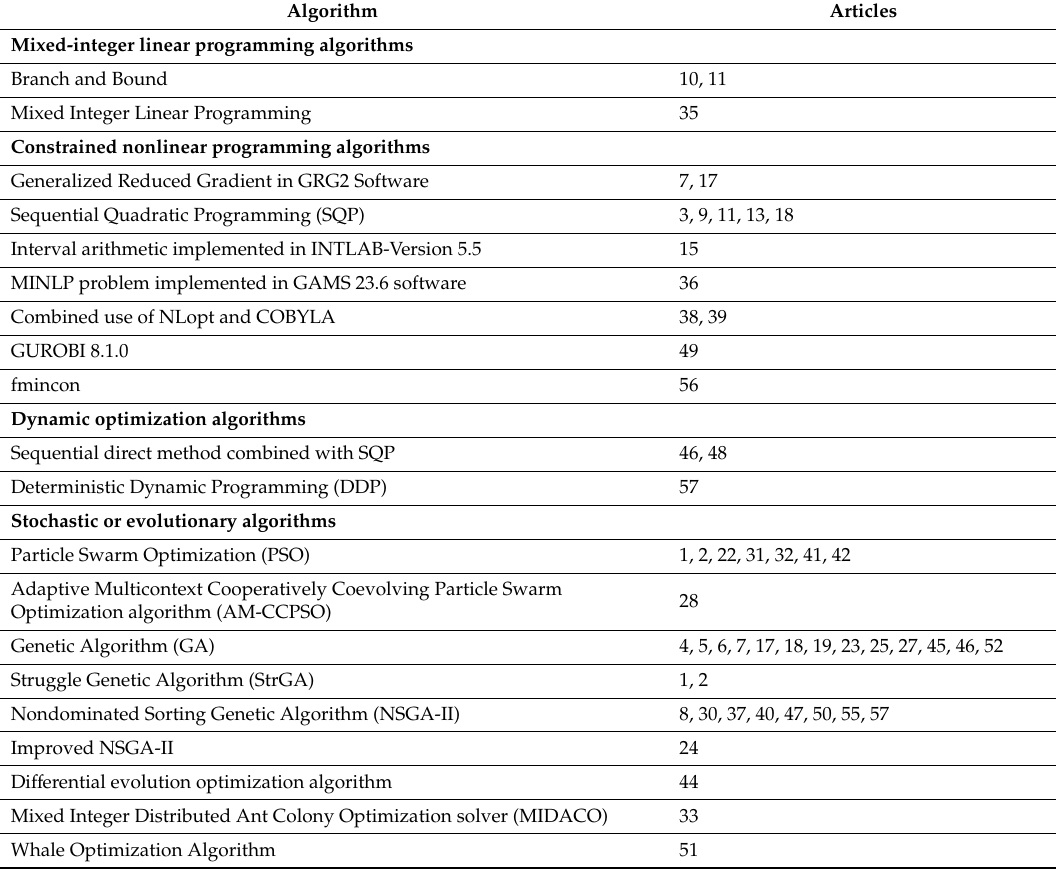
Table 5. Algorithms and / or software used in the articles of Table 1. Algorithm